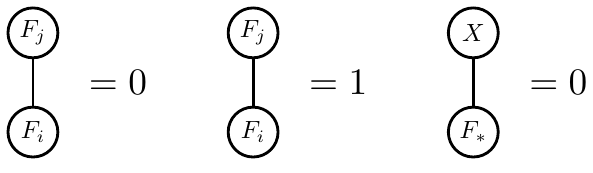
Figure 7: Decorated constraints forcing the structure of some of the tiles involving parts from F ∗ . The first constraint should hold for all i , j ∈ [ M ] such that i + j ≤ M , the second for all i , j ∈ [ M ] such that i + j ≥ M + 2, and the last for all X ∈ { B